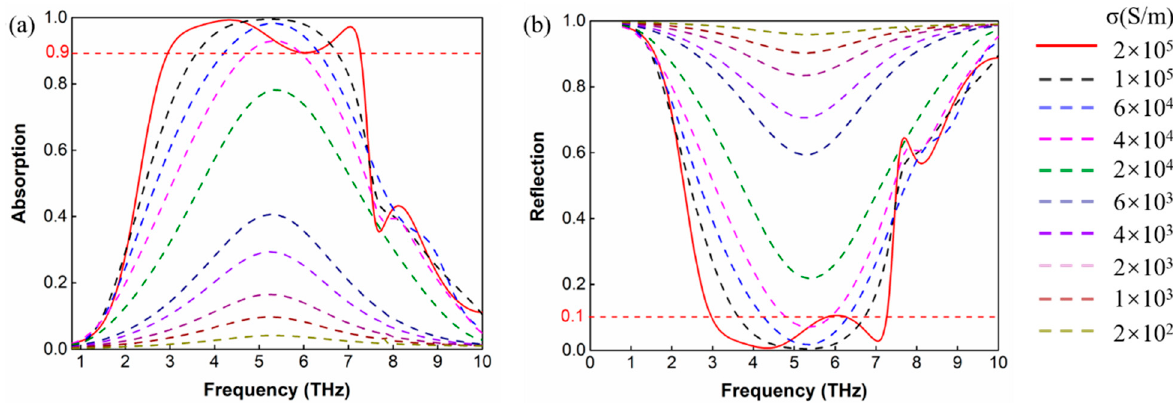
Figure 3. ( a ) Absorption spectrum and ( b ) reflection spectrum of absorber under different conductivities of VO 2 .